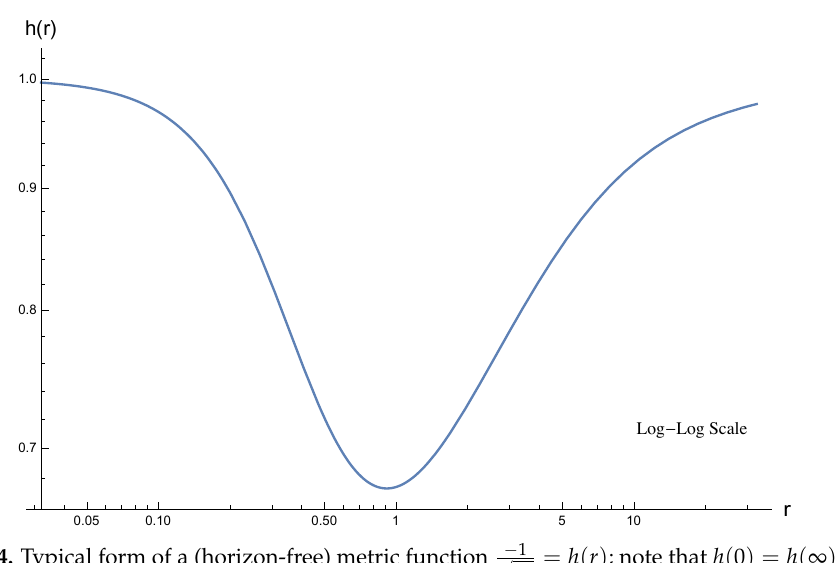
Figure 4. Typical form of a (horizon-free) metric function − 1 √